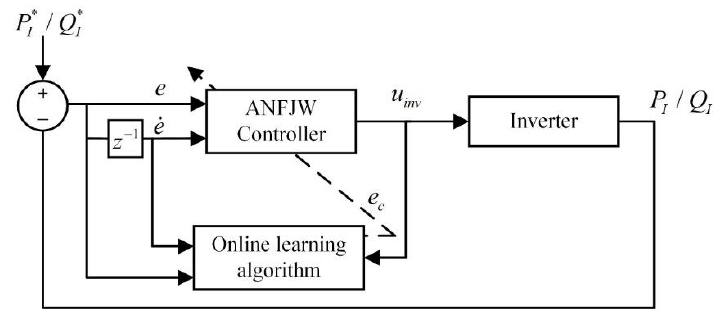
Figure 7. Working of the proposed strategy.